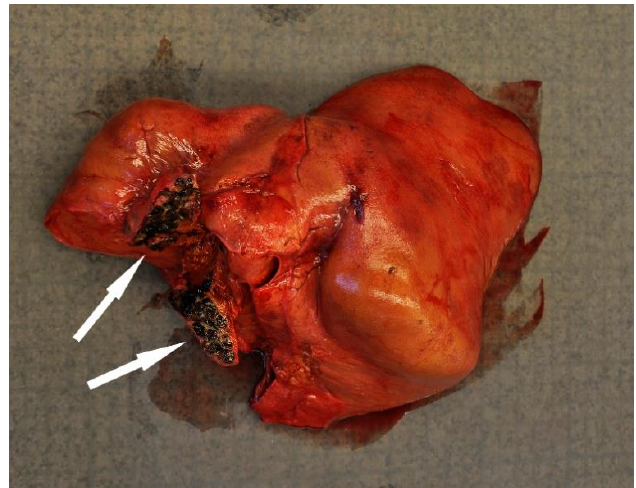
Figure 4. The liver from a harbour porpoise ( Phoceona phocoena ) with a locally extensive biliary trematode infection (black discoloured area shown by arrows) that obstructed bile flow. The liver is discoloured bronze-yellow and the animal had generalized icterus.